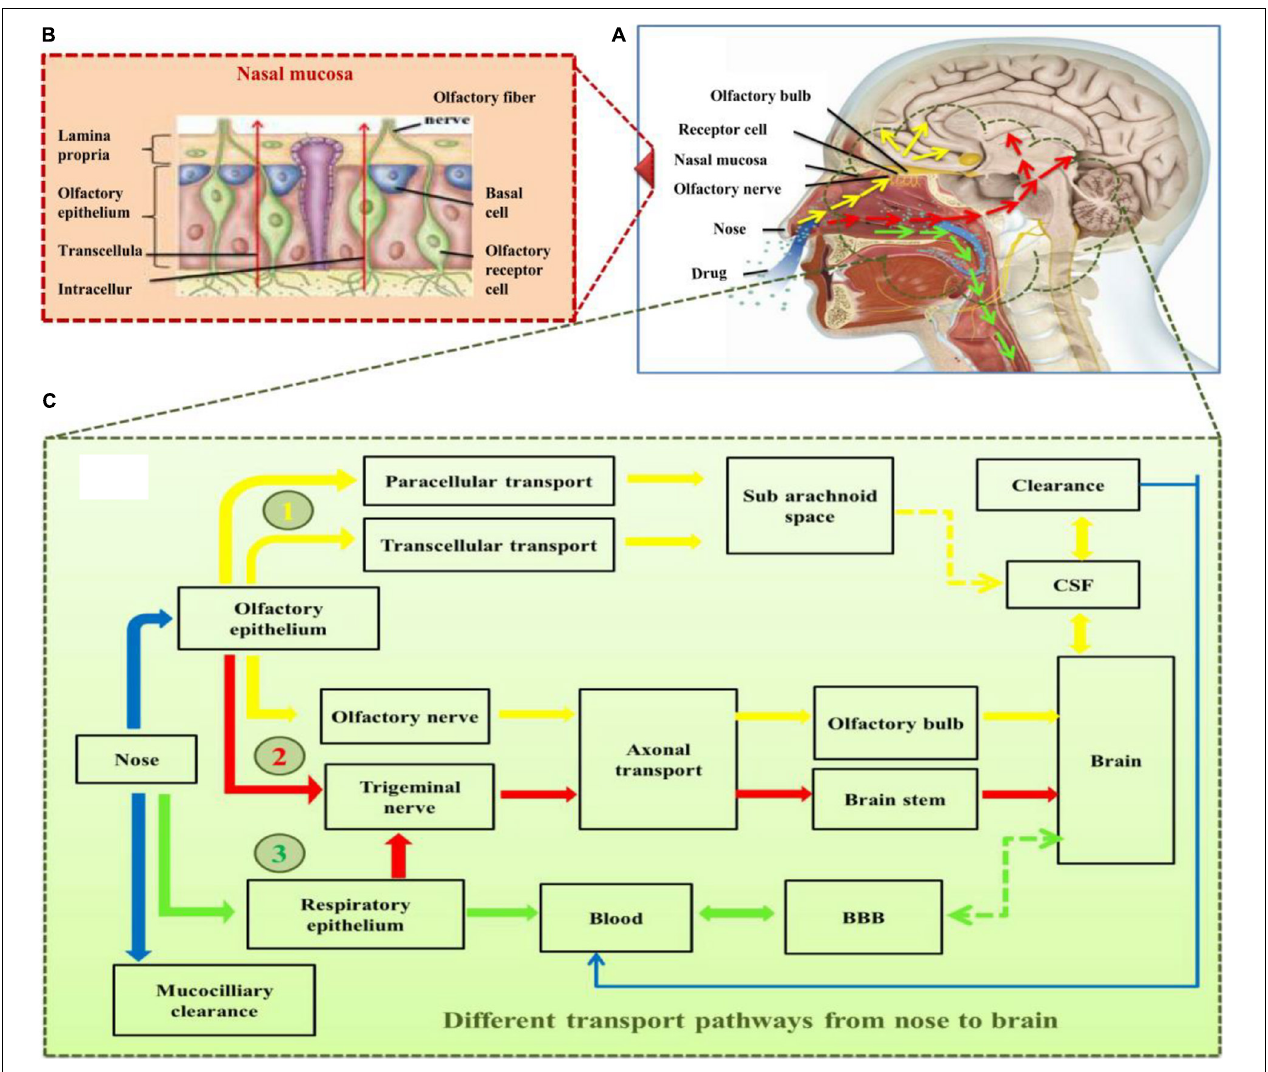
FIGURE 2 | (A) Skull structure presenting major components of nose and brain involved in drug transport to the brain, (B) structural components of nasal mucosa, (C) the various pathways (highlighted in different colors; yellow, red, and green) for the delivery of drugs into the brain through intranasal route. Yellow arrows present the major direct pathway involving the olfactory nerve, red arrows present the pathway primarily involving the germinal nerve route, and green arrows illustrate the minor pathway involving blood–brain barrier (BBB) following the systemic absorption of the drug molecules through respiratory epithelium. BBB, blood–brain barrier; CSF, cerebrospinal